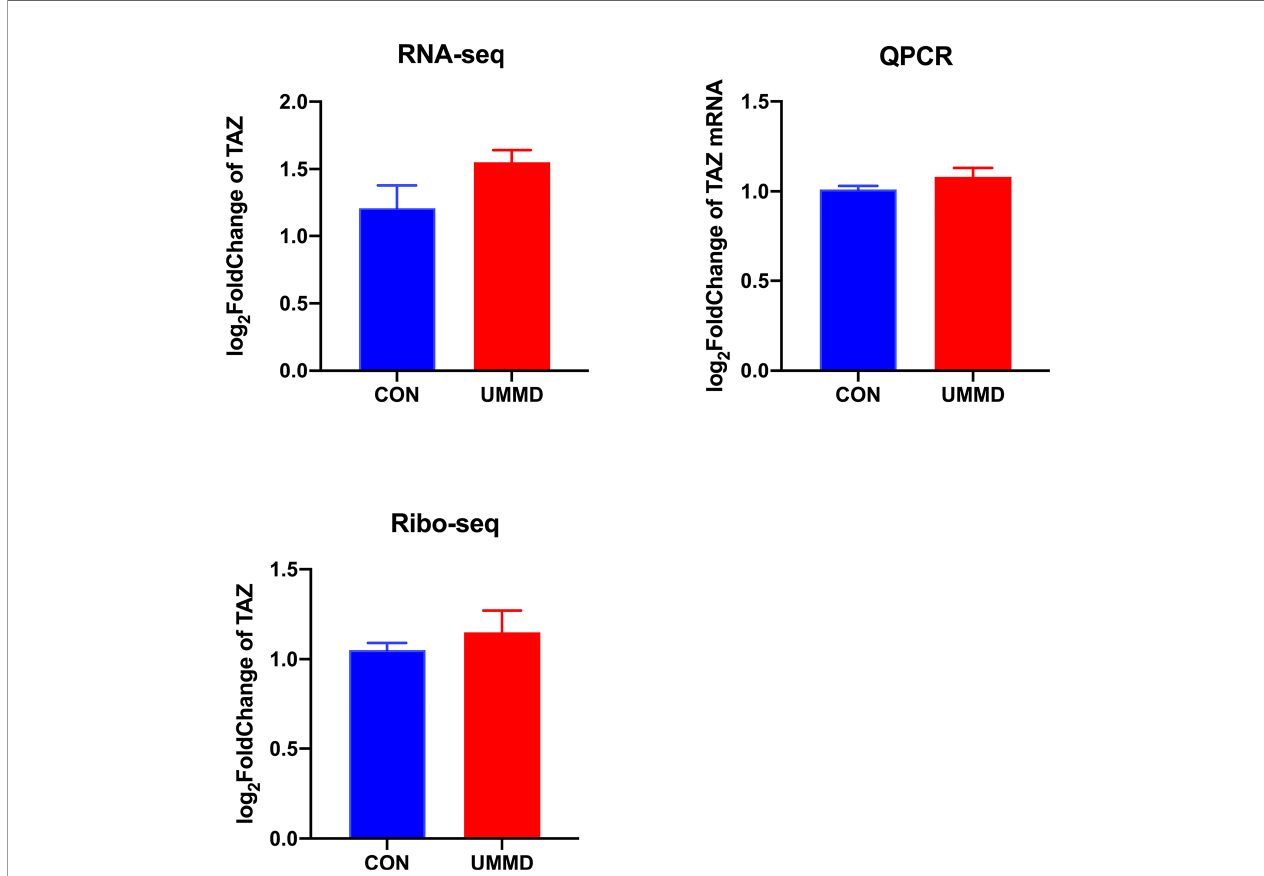
FIGURE 4 | UMMD treatment in vivo does not affect TAZ expression. (A) RNA-seq detection of TAZ expression in CMM mouse tumor tissues; (B) RT-qPCR detection of TAZ mRNA expression in CMM mouse tumor tissues; (C) Ribo-seq detection of TAZ expression in CMM mouse tumor